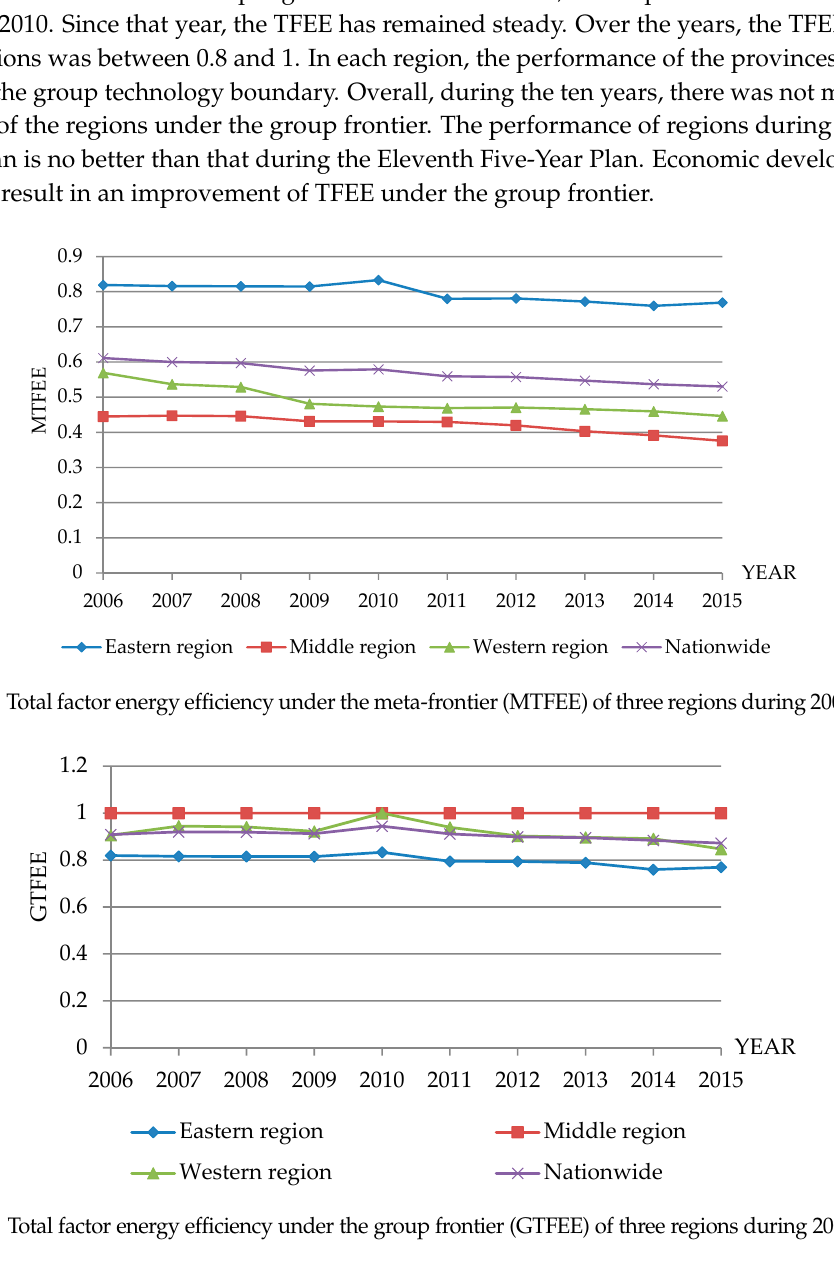
Figure 3. Total factor energy efficiency under the group frontier (GTFEE) of three regions during 2006–2015.